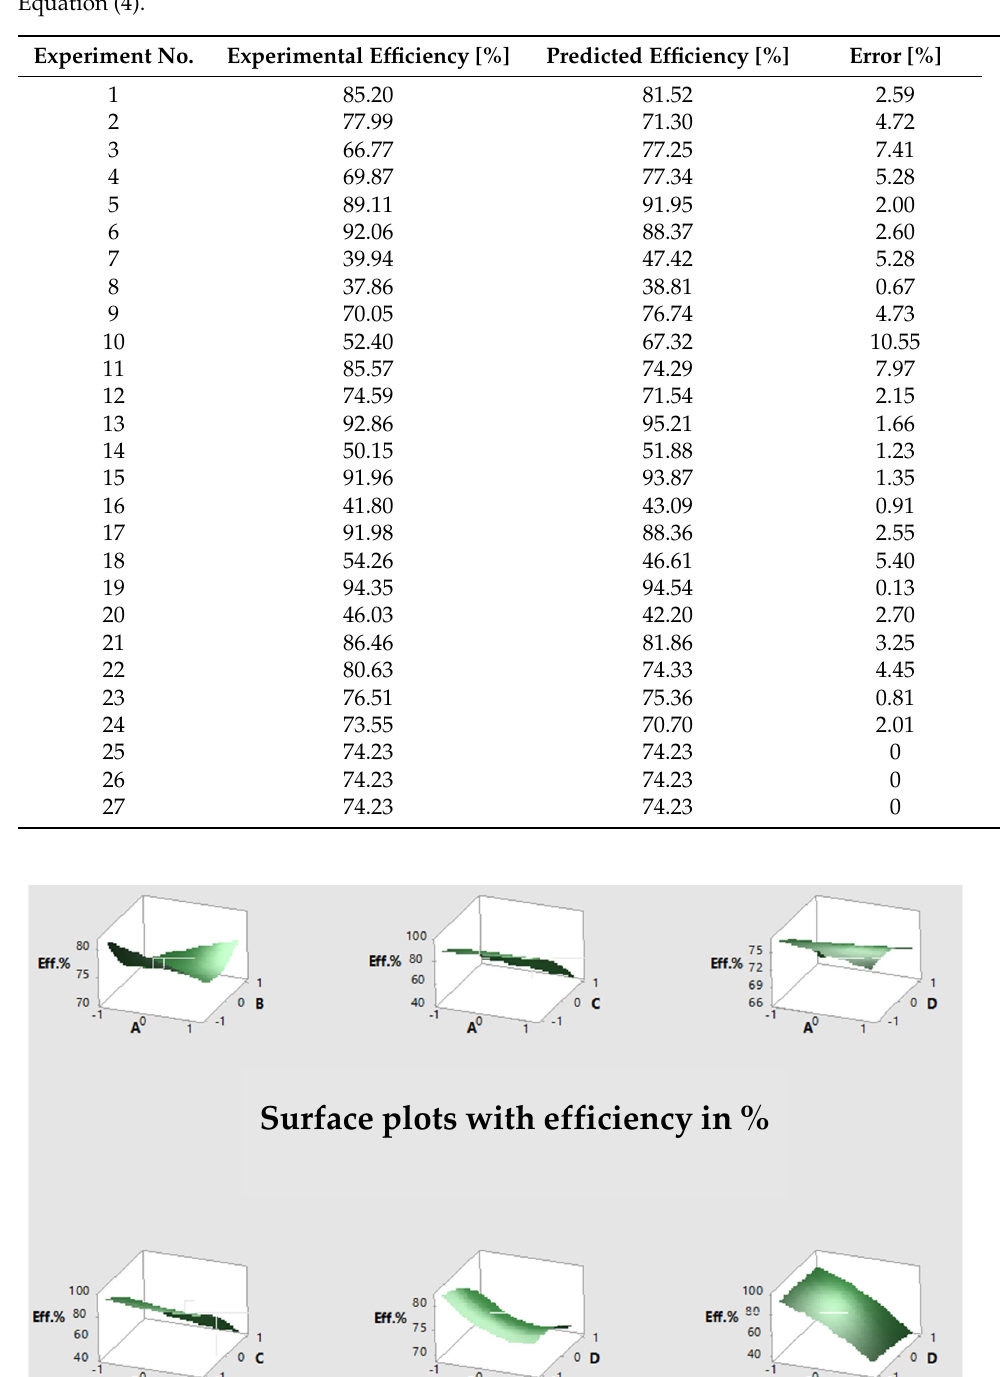
Table 6. The actual experimental efficiency and the efficiency predicted by the model according to Equation (4).